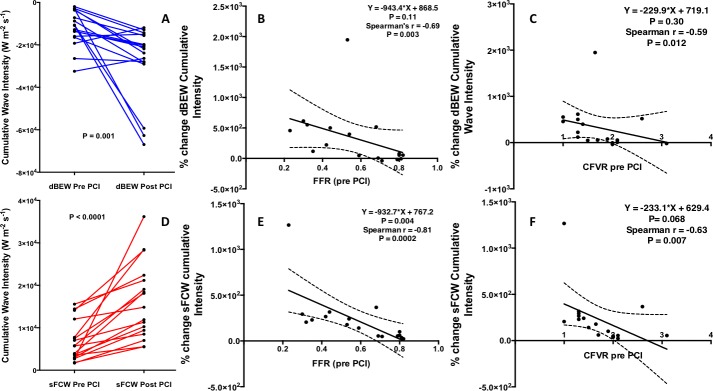
Effect of PCI on accelerative wave intensity and relationship with pre-PCI FFR and CFVR.
(A) Cumulative intensity of the dBEW measured during hyperemia before and after PCI, (B) Percentage increase in dBEW intensity and pre-PCI FFR. PCI to lesions with the lowest baseline FFR values resulted in the largest percentage increase in diastolic suction wave intensity, whereas PCI to lesions with an FFR of close to 0.80 resulted in minimal increases. (C) Percentage increase in dBEW intensity and pre-PCI CFVR, (D) Cumulative intensity of the sFCW measured during hyperemia before and after PCI. (E) Percentage increase in sFCW intensity and pre-PCI FFR. PCI to lesions with the lowest baseline FFR values resulted in the largest percentage increase in sFCW intensity, whereas PCI to lesions with an FFR of close to 0.80 resulted in minimal increases. (F) Percentage increase in the sFCW intensity and pre-PCI CFVR. FFR, Fractional Flow reserve; CFVR, Coronary Flow Velocity Reserve; sFCW, systolic Forward travelling Compression Wave; dBEW, diastolic Backward travelling Expansion Wave.